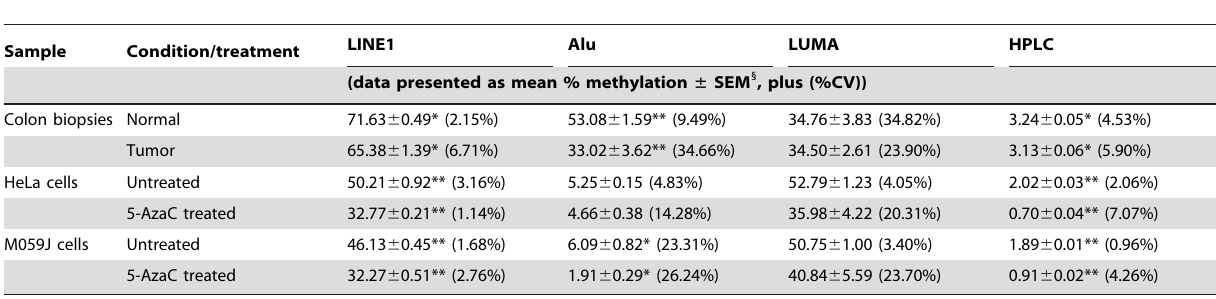
Table 4. Absolute values for global DNA methylation estimated by 4 different methods.